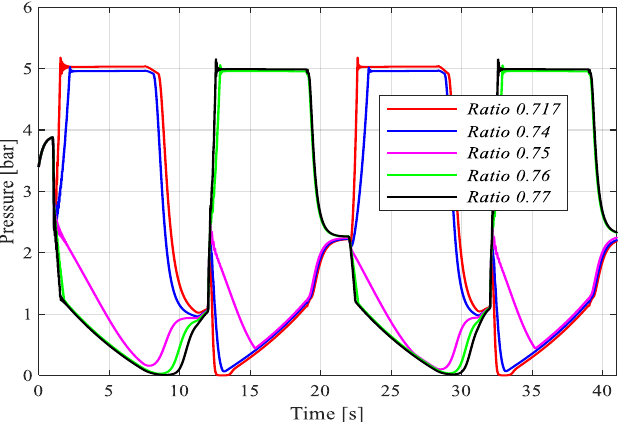
Figure 17. Pressure in the rod chamber for different displacement ratios. Cracking pressure = 5 bar.